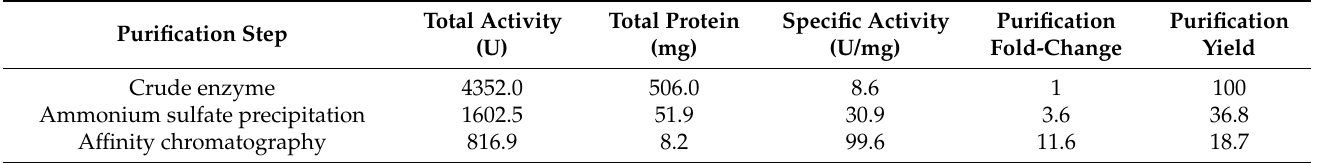
Table 1. Summary of the purification of Bacillus subtilis 15A-B92 pectinase.